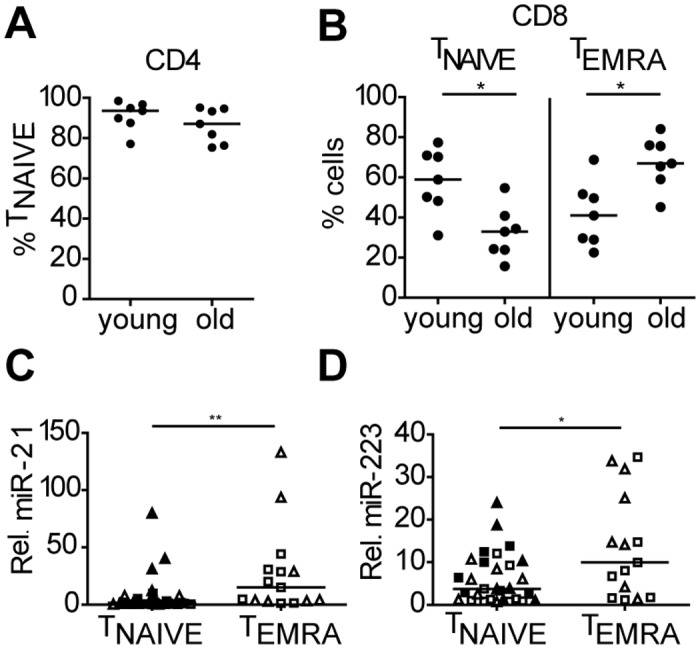
Age-related upregulation of miR-21 and miR-223 can be partly explained by the accumulation of TEMRA (CD8 T cells) in the CD45RO- T-cell compartment.Percentage of (A) TNAIVE CD4+CD45RO-CCR7+ and (B) TERMA CD4-CD45RO-CCR7- T cells in young and old donors. Relative expression of (C) miR-21 and (D) miR-223 in TNAIVE (CD4 and CD8) and TERMA (CD8) T cells in young vs old donors. MiRNA expression was normalized to the expression of RNU49 (Lines indicate median). Squares indicate cells from young and triangles cells from elderly donors. Filled symbols indicate CD4+ T cells and open symbols indicate CD8+ T cells. *p ≤ 0.05, **p ≤ 0.01.